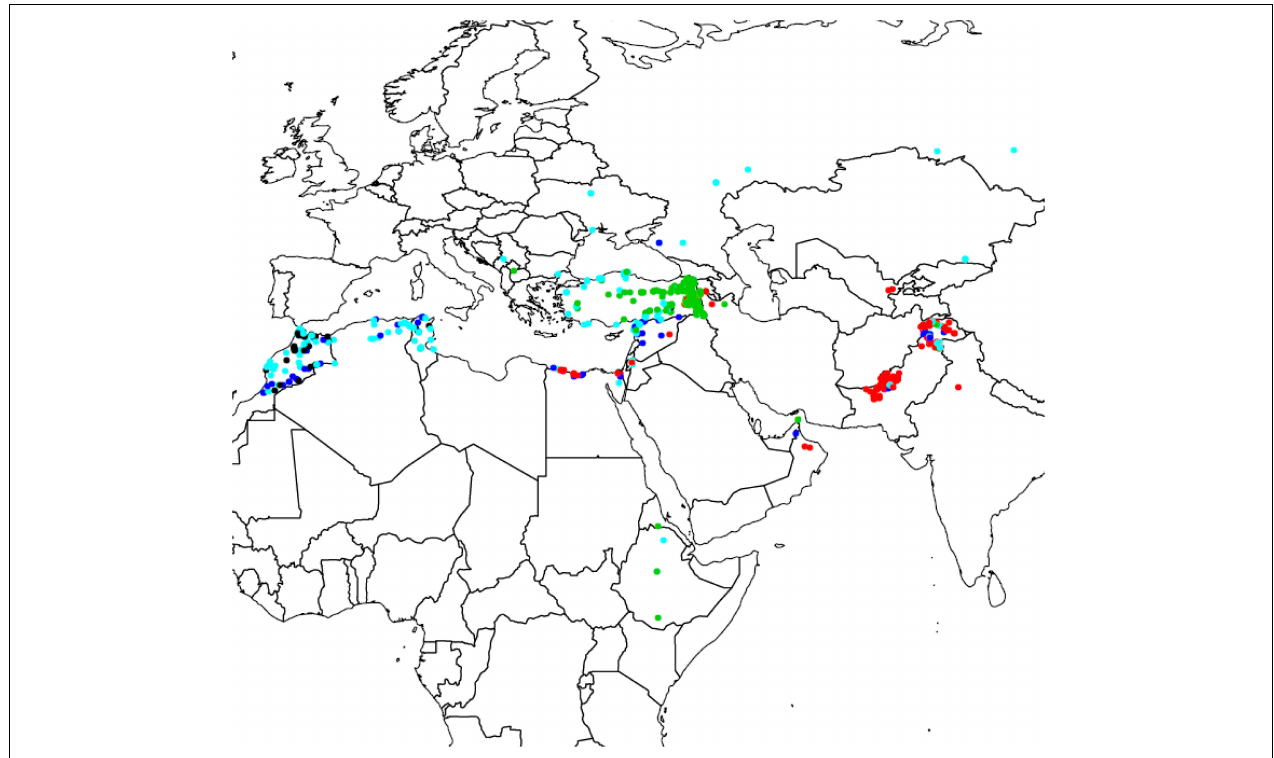
FIGURE 2 | Geographic distribution of the five subpopulations of bread wheat landraces found using Discriminant Analysis of Principal